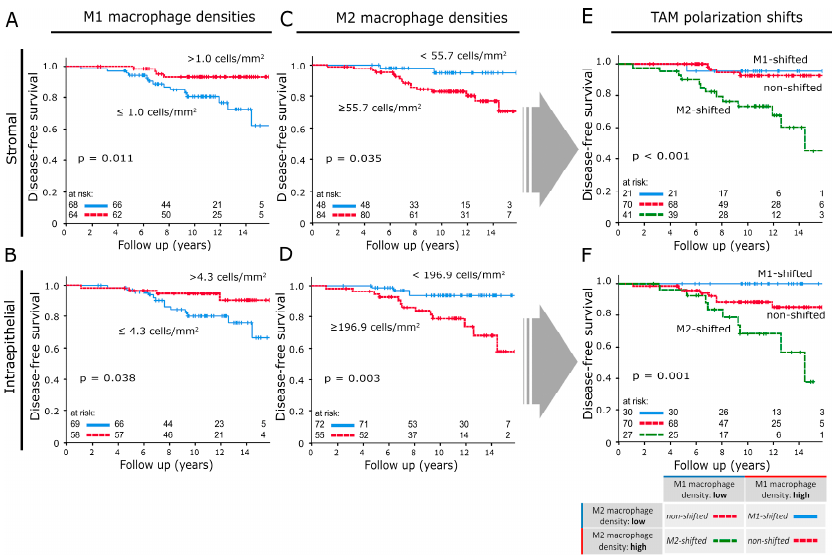
Figure 2. Disease-free survival analysed with the Kaplan–Meier method and log-rank test according to macrophage densities in invasive front samples: ( A , B ) M1 macrophage densities in the stromal and intraepithelial compartment. ( C , D ) M2 macrophage densities in the stromal and intraepithelial compartment. ( E , F ) Disease-free survival according to TAM polarisation shift classifications applied to the stromal and intraepithelial compartment of invasive front samples. The table located in the lower right section explains how results from ( A – D ) were combined to create the TAM shift